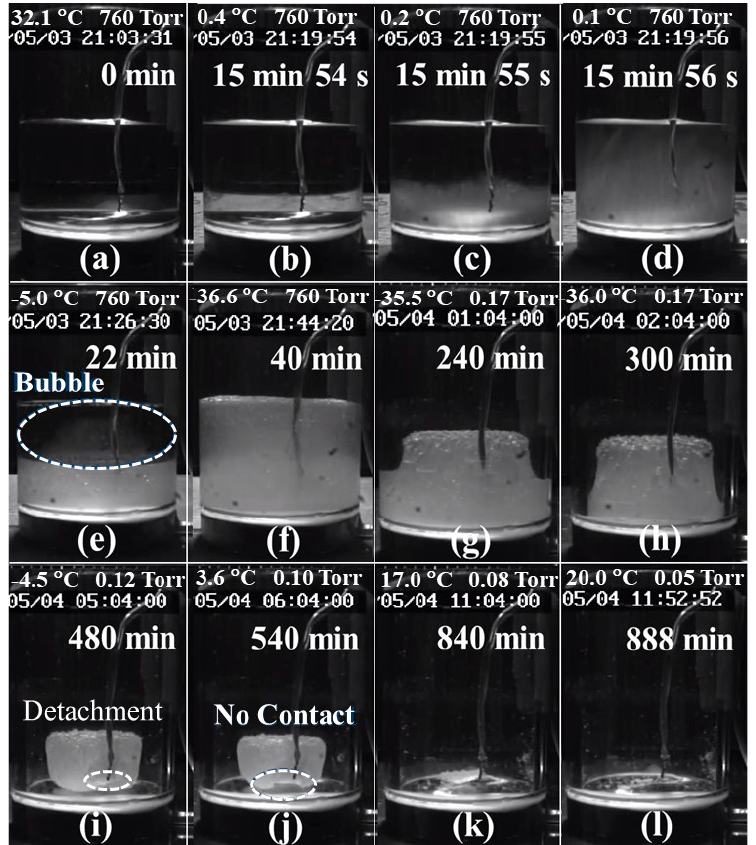
Figure 8. Photographs of the water / ice in the container during the freeze-drying process along with the corresponding process times of ( a ) 0 min, ( b – d ) 15 min 54~56 s, ( e ) 22 min, ( f ) 40 min, ( g ) 240 min, ( h ) 300 min, ( i ) 480 min, ( j ) 540 min, ( k ) 840 min and ( l ) 888